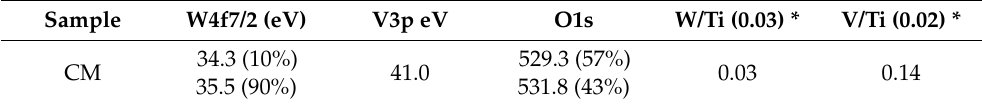
Figure 5. XP survey spectrum of the monolithic catalyst (as a slab). The blue inset is the O1s + V2p region, the red inset is the Ti2p region. Table 6. XPS results in terms of W4f, V3p and O1s binding energies (eV) of the monolithic device and W/Ti and V/Ti atomic ratios. The relative intensities of the different components of V and O are given in